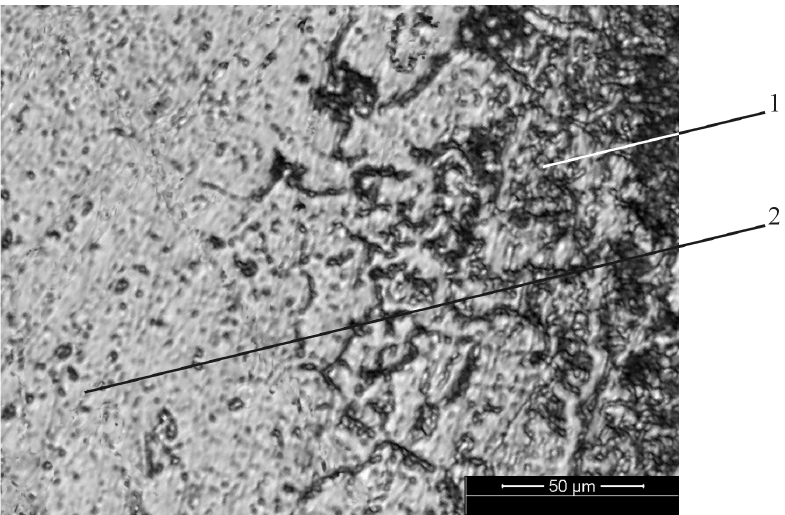
Figure 5. Structure of sheet material from a 5251 H18 aluminum alloy after laser annealing: 1—annealing zone, 2—initial structure [92]. Reproduced with permission from [Murzin, S.P], [Lasers in Engineering article]; published by [Lasers in Engineering article],